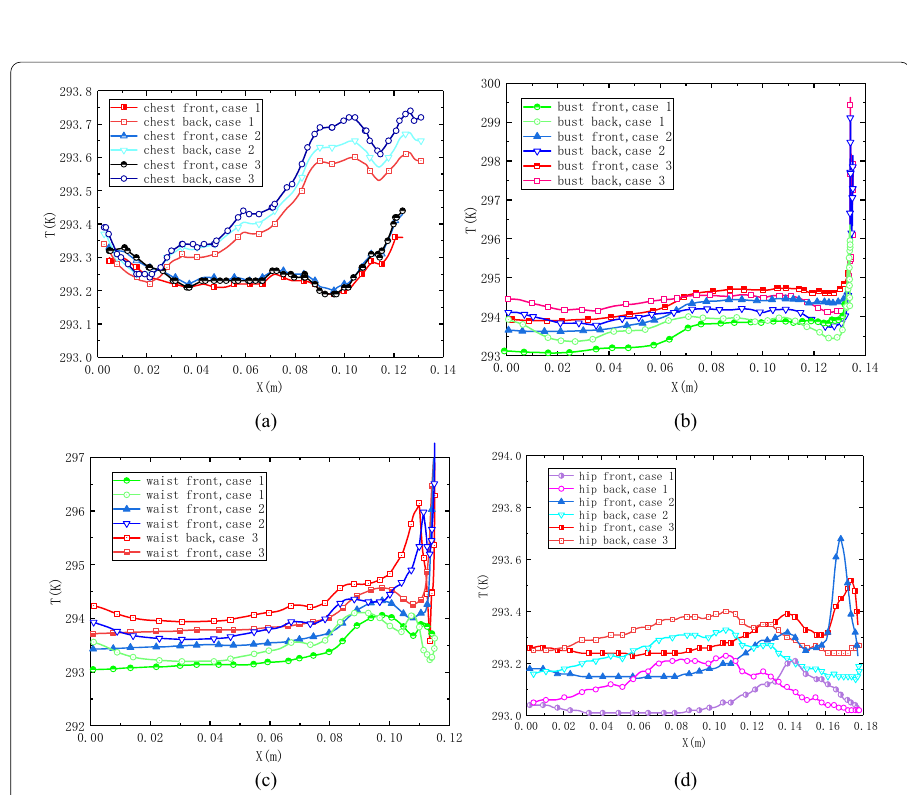
Fig. 6 Temperature distribution on garment surface. a Chest girth, b bust girth, c waist girth, d hip